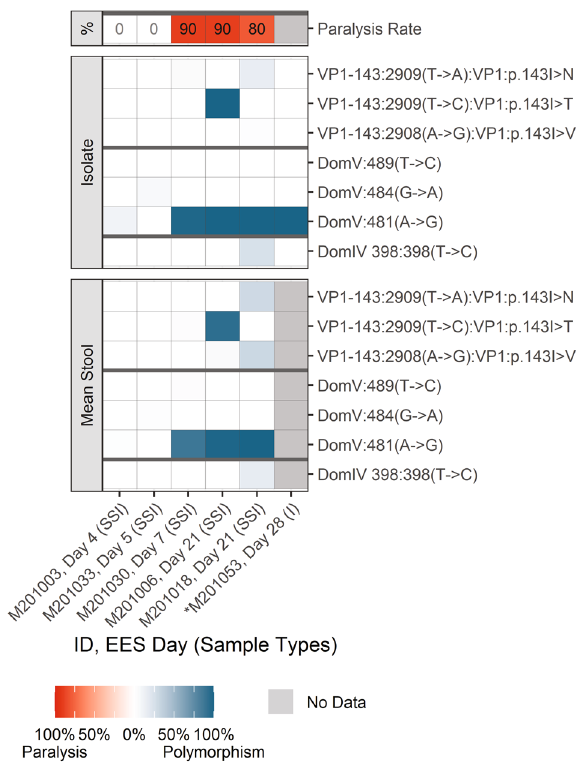
Fig. 2 mOPV2. Frequency of polymorphisms in EES at known attenuation sites and mTgmNVT results. EES day shown with mTgmNVT result (red color gradient) and polymorphism frequency (blue color gradient) averaged across two stool replicates (SS) and culture-ampli fi ed virus (I), if present. Amino acid associated with SNP indicated, if applicable. S = Stool replicate; I = Culture-ampli fi ed virus isolate (SSI = Two stool replicates and culture-ampli fi ed virus isolate; SI = Single stool replicate and isolate). White cells = polymorphism not detected. Gray cells = mTgmNVT result not available or no NGS data from stool (S)/ culture-ampli fi ed virus (I). *Day 28 = Insuf fi cient titer to test EES in mTgmNVT. The NGS pipeline reports SNPs. Coding impact assumes changes are not in common genomes when multiple polymorphisms are observed in VP1-143. All SNPS reported have Quality scores (Q scores) ≥